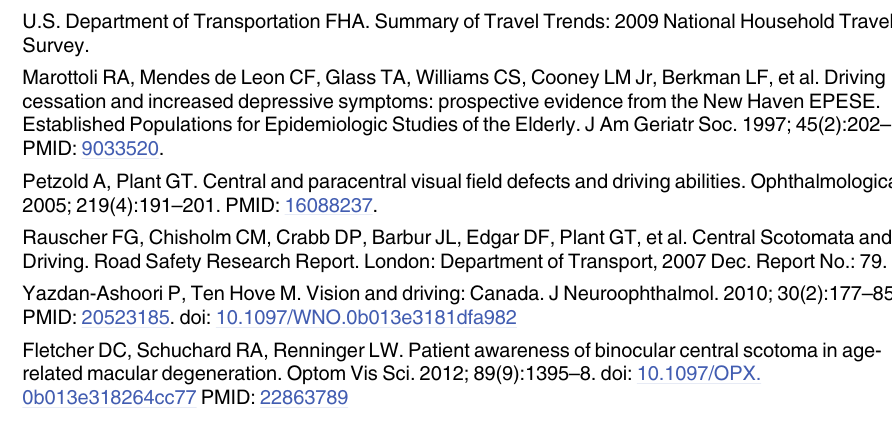
S1 Fig. Individual proportion of untimely responses for pedestrians at small and large eccentricities. Data for each participant with Central Field Loss (CFL) and each Normal Vision (NV) participant are connected by black and grey straight lines, respectively. In general, partic- ipants with CFL had much higher untimely response rates than NV controls, particularly for pedestrians at small eccentricities and on rural highways. Controls also had more untimely reactions in rural highway than city drives. S2 Fig. Mean reaction times for vertical central field loss (CFL) participants in this study and lateral CFL participants from the prior study [14]. Compared to those with vertical field loss, participants with lateral field loss had considerably longer reaction times to pedestrians likely to be obscured ( “ likely obscured ” vs. ±4°), but similar reaction times to pedestrians not likely to be obscured ( “ seeing ” vs. ±14°). Error bars represent 95% confidence interval. S1 Table. Multiple regression results. S2 Table. Gaze tracker data available for